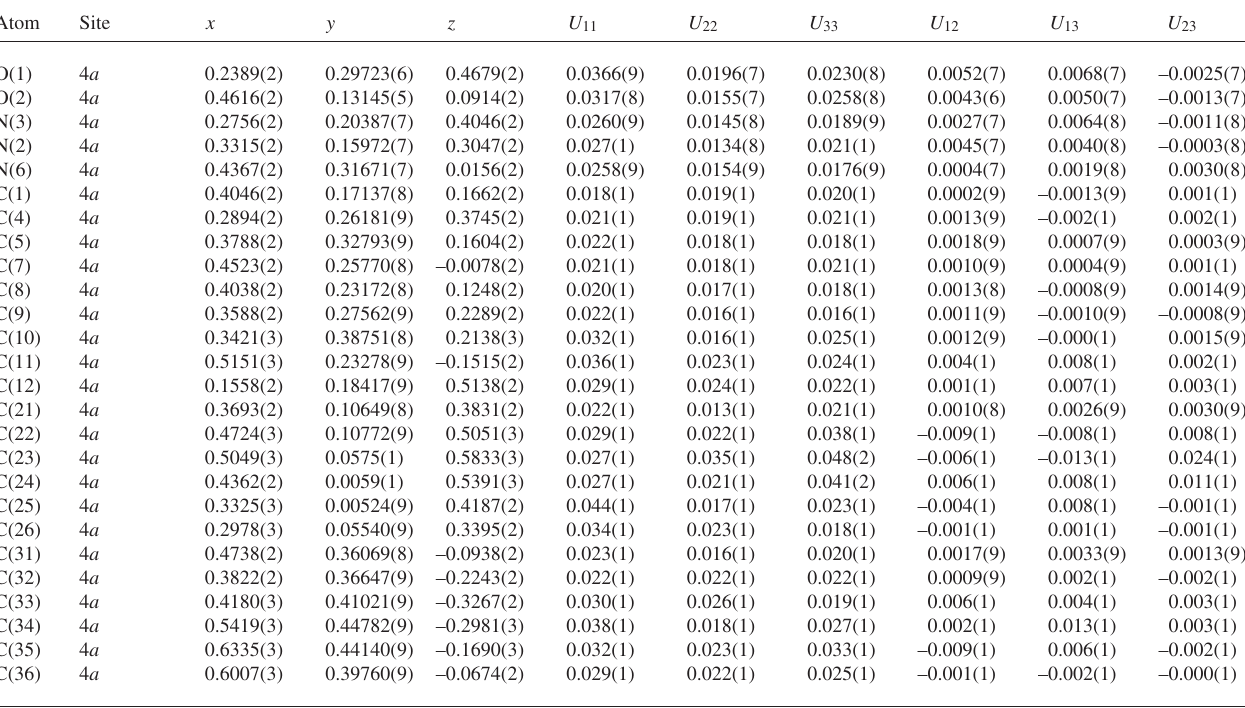
Table 3. Atomic coordinates and displacement parameters (in Å 2 )